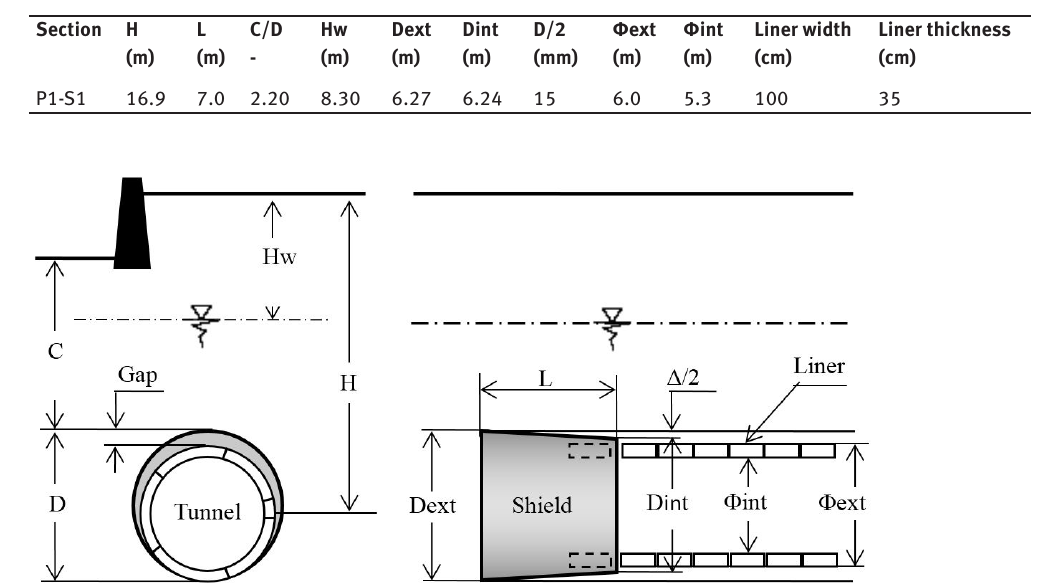
Figure 4: Tunnel, shield, and liner parameters.